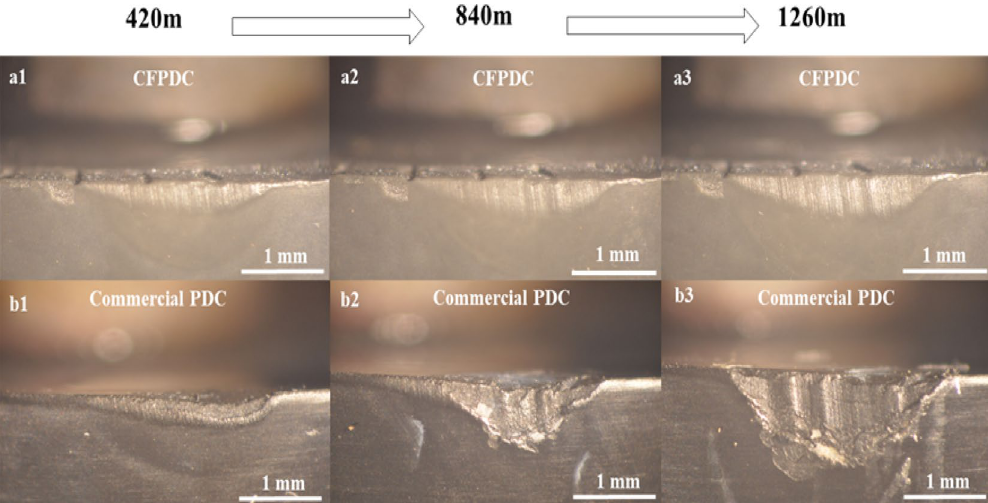
Figure 3. Wear flats of CFPDC and Commercial PDC samples. Optical pictures for the cutting edge of CFPDC sample (upper) with turning length of ( a1 ) 420 m, ( a2 ) 840 m, and ( a3 ) 1260 m; and pictures for the cutting edge of commercial PDC sample (lower) with a cutting length of ( b1 ) 420 m, ( b2 ) 840 m, and ( b3 ) 1260 m, respectively.